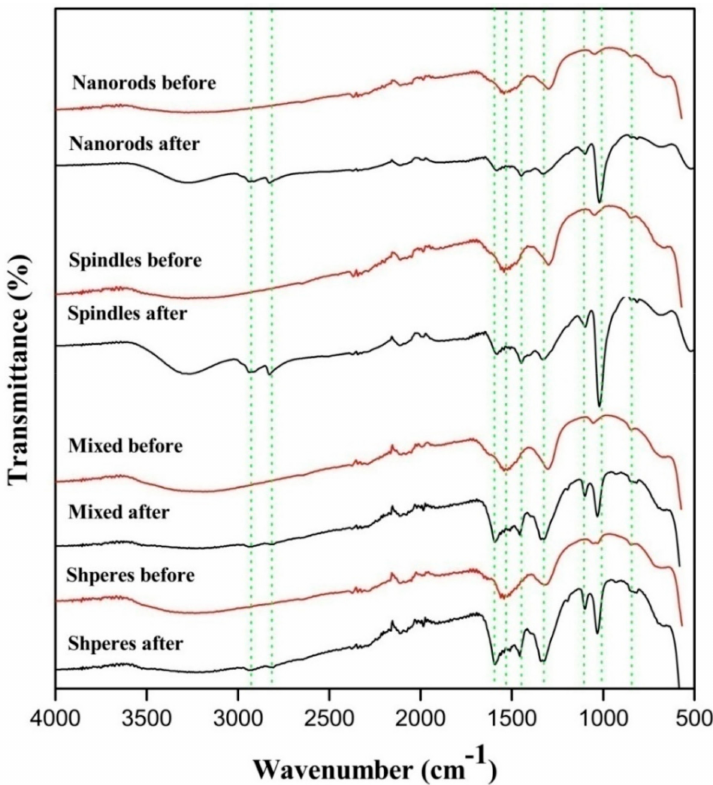
Figure 9. Samples before and after exposure to CO 2 and methanol